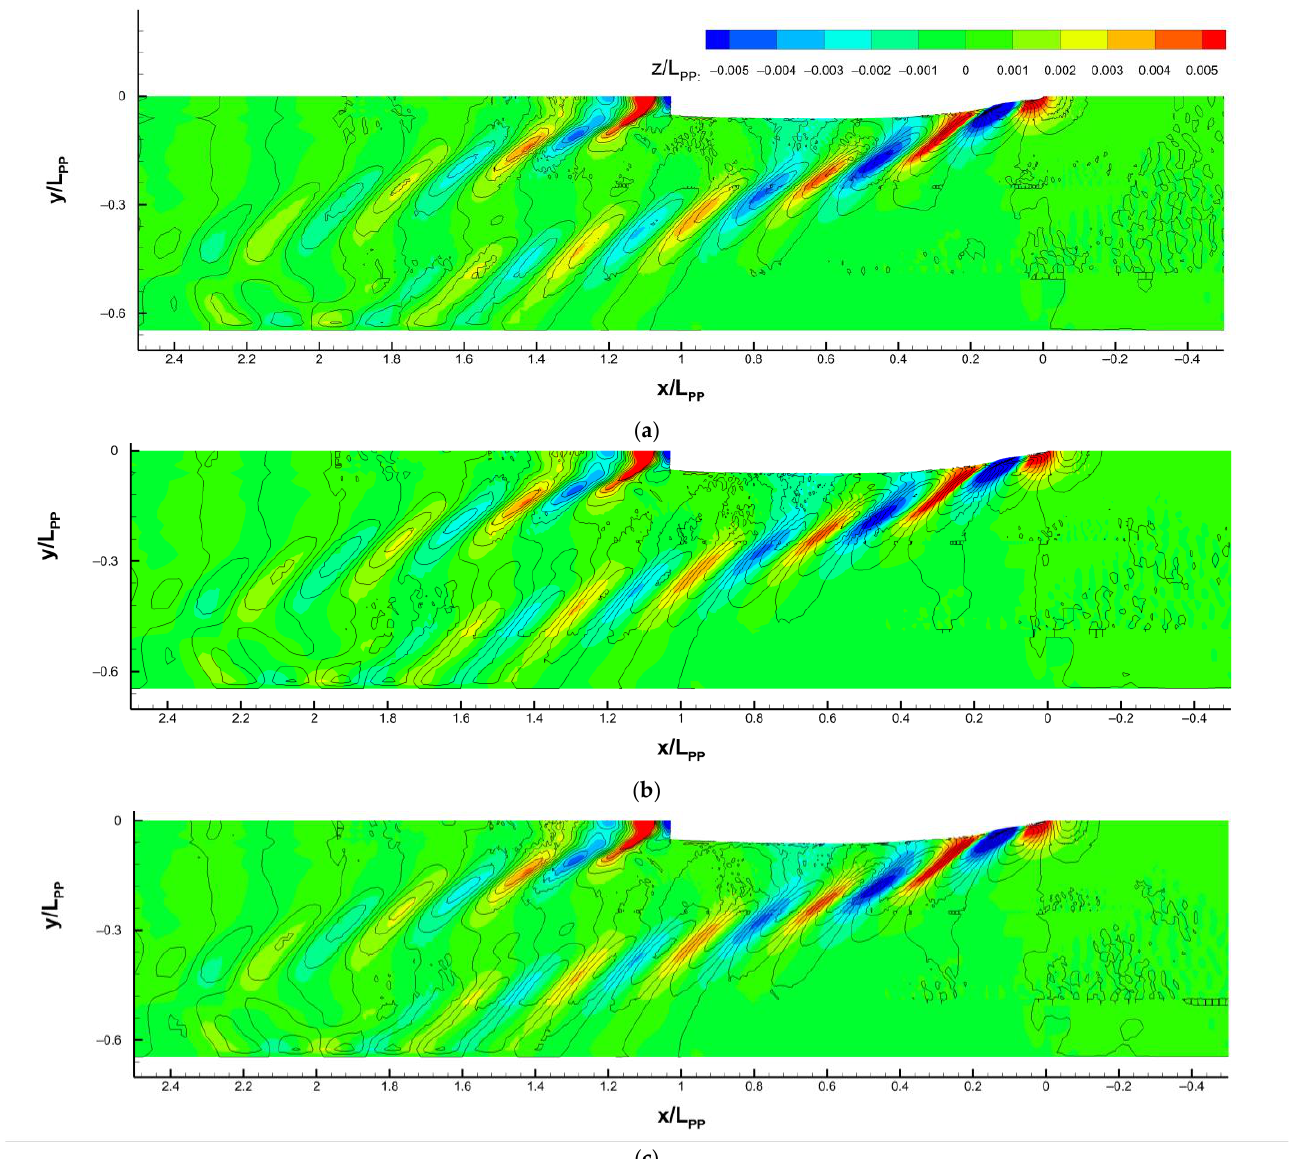
Figure 10. Overlapping comparison for wave pattern between F0 (flooded color contour) and ( a ) F0.14 (black contour lines); ( b ) F0.225 (black contour lines); ( c ) F0.24 (black contour lines).